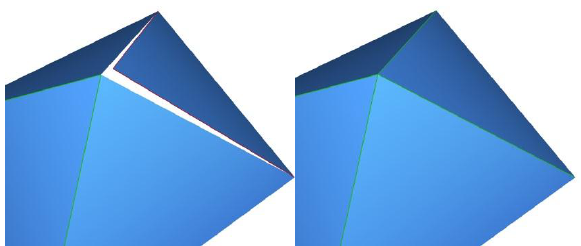
Figure 3. Left: incorrect topology. Right: correct topology.